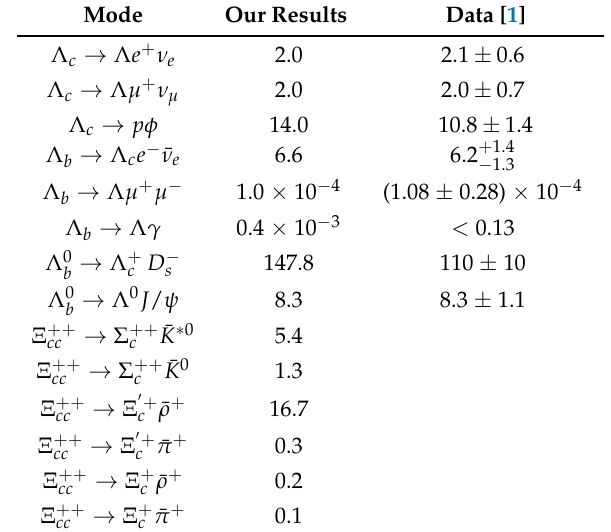
Table 1. Branching ratios of weak decays of single and double heavy baryons (in %).